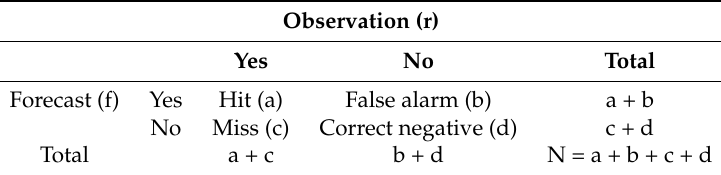
Table 5. Contingency table used to obtain the skill scores.